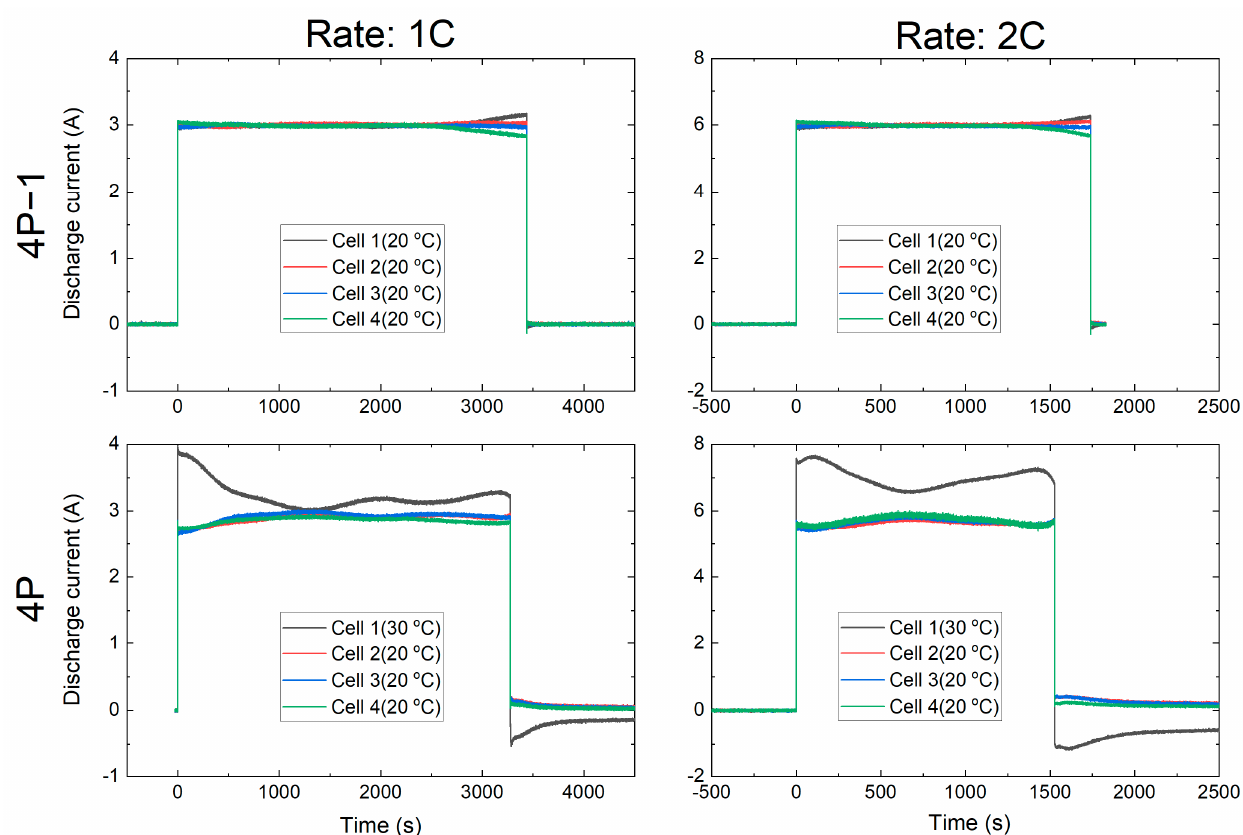
Figure 4. Current distribution within the parallel-connected cells during discharge capacity test at 1C and 2C discharge rates for different parallel configurations.